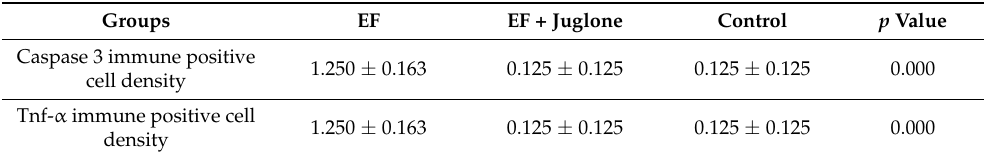
Table 4. Statistical evaluation of Caspase-3 and tnf- α immune positive cell density of the groups by Kruskul–Wallis method ( p > 0.05)